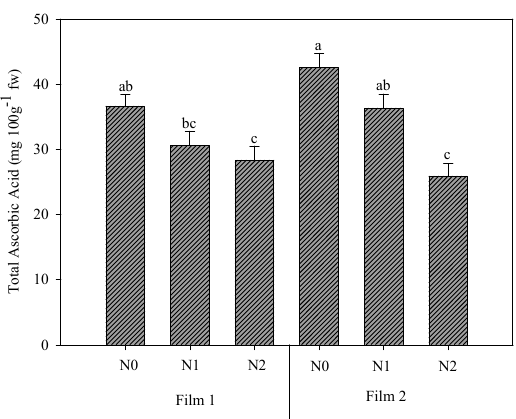
Figure 1. Effect of plastic films and nitrogen fertilization strategies on total ascorbic acid (TAA). Different letters indicate significant differences at p = 0.05 according to Tukey’s multiple range test. The total ascorbic acid content of rocket changed in the harvest periods, with the highest values recorded in November and February and similar lower values from March to May (Figure 2).